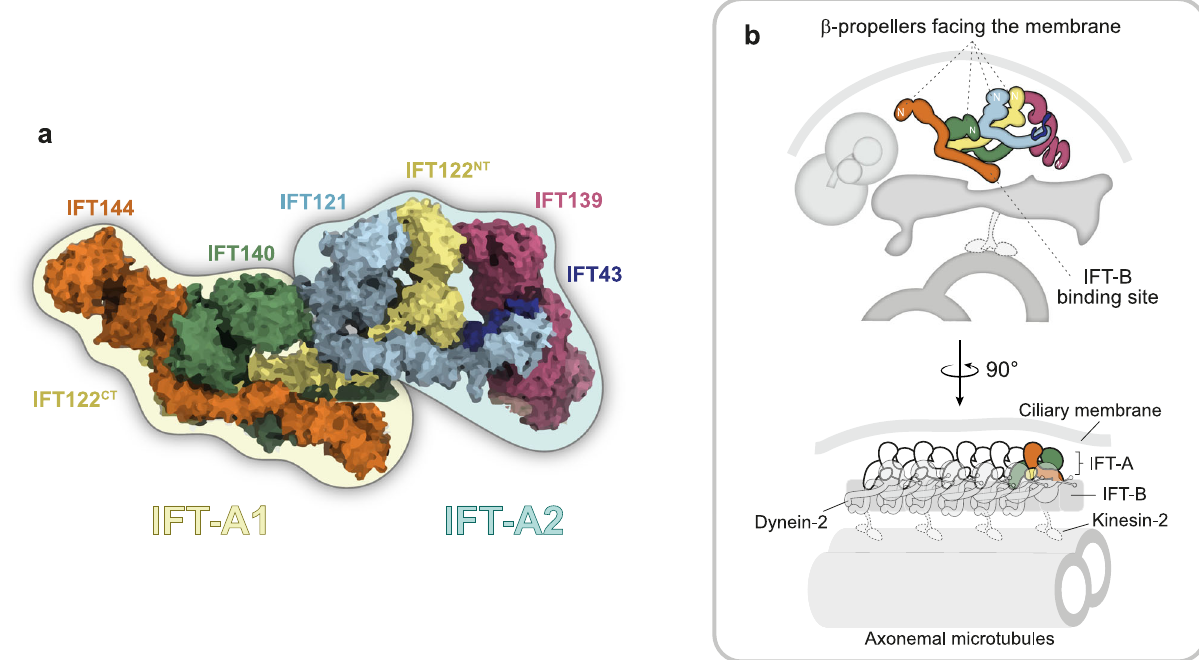
Fig. 1 Structural representation of the complete IFT-A complex when docked into the cryo-ET map of anterograde IFT trains from C. reinhardtii . a The IFT-A complex subdivided into two modules: IFT-A1 (highlighted in light yellow) and IFT-A2 (highlighted in light blue). IFT-A1 encompasses IFT144, IFT140 and the C-terminal region (CT) of IFT122, while IFT-A2 is composed of IFT121, IFT139, IFT43, and the N-terminus (NT) of IFT122. b Illustration of IFT-A in orthogonal views relative to IFT-B, axoneme, ciliary membrane, Dynein-2 and Kinesin-2 (inferred position, for context; not to scale). The N-terminal region of each IFT-A subunit is indicated by N in white. Artwork by: Maria J. G.